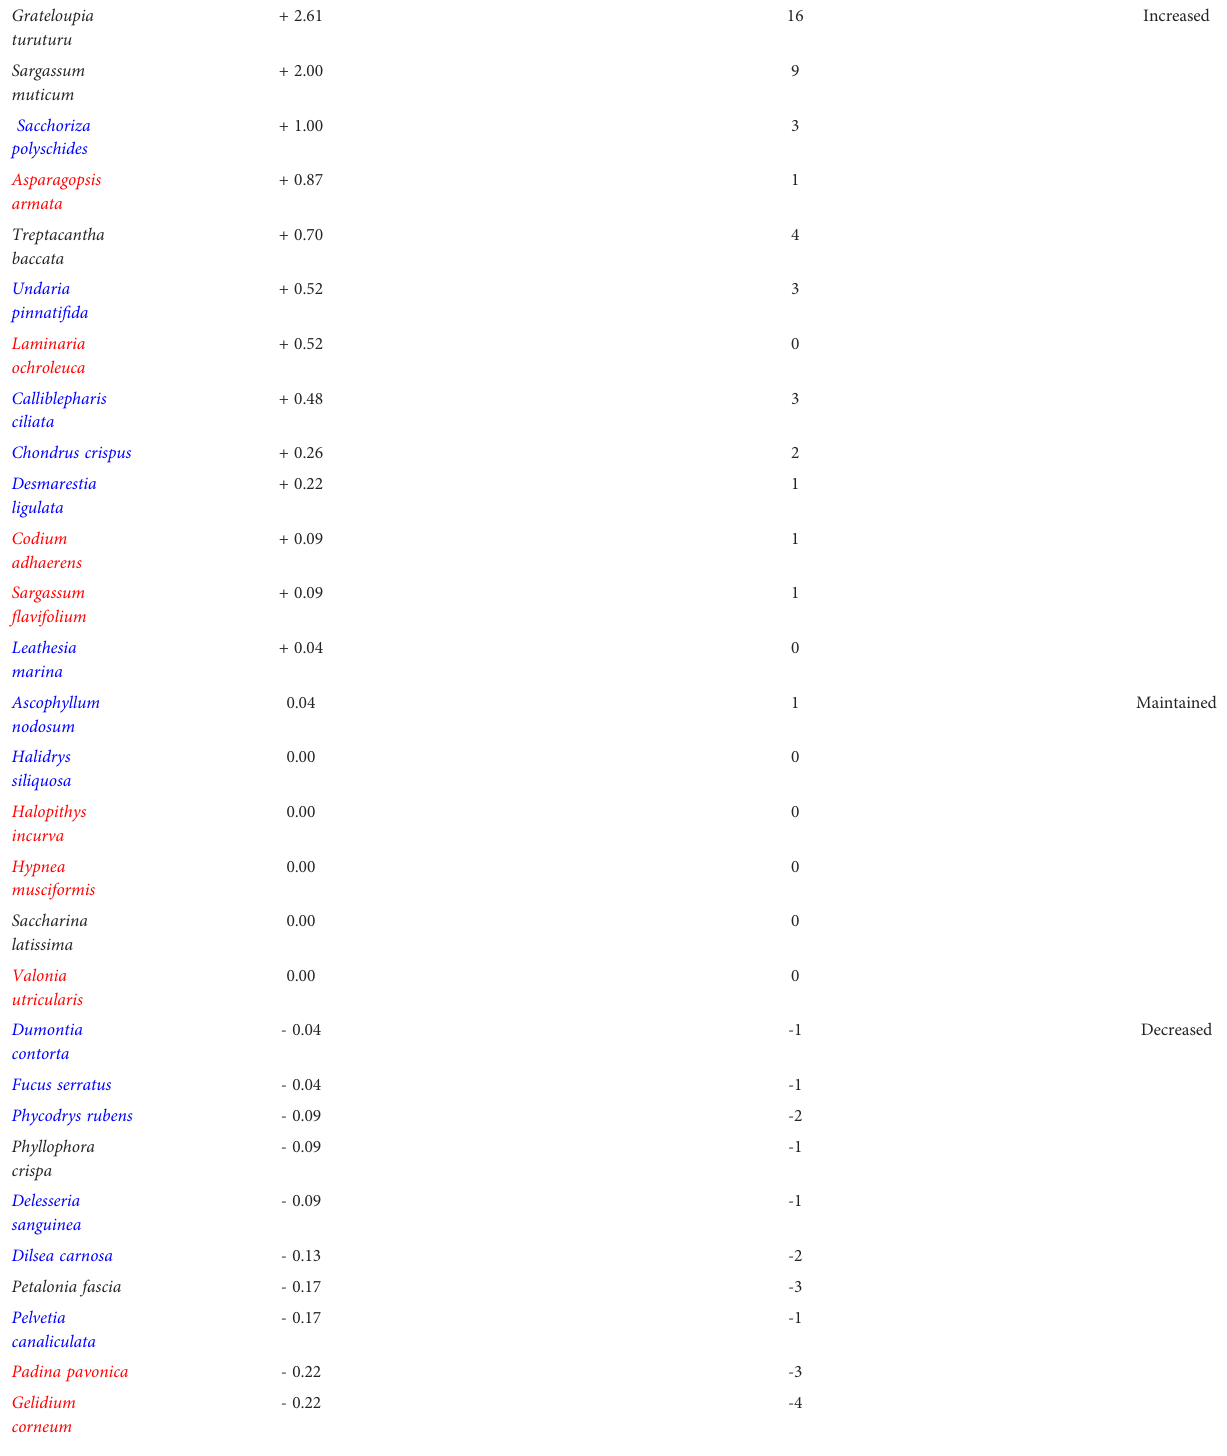
TABLE 1 Description of species that increased, decreased, or maintained their average abundance and geographical distribution from historical (2001-2005) to present-day data (2020-2021). Species Average difference in SACFOR Difference in the number of locations where the species was observed abundance score in present-day vs. historical